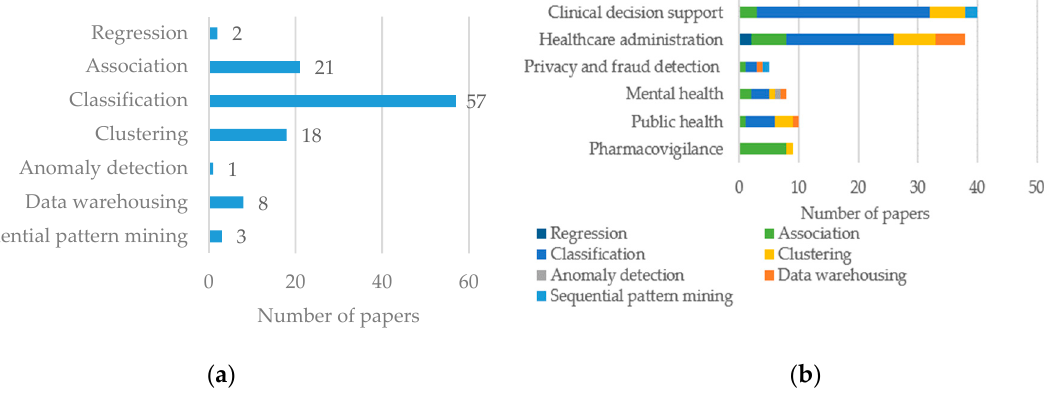
Figure 8. Utilization of data mining techniques, ( a ) by percentage and ( b ) by application area. A high proportion (8 out of 9) of pharmacovigilance papers used association. Use of classification